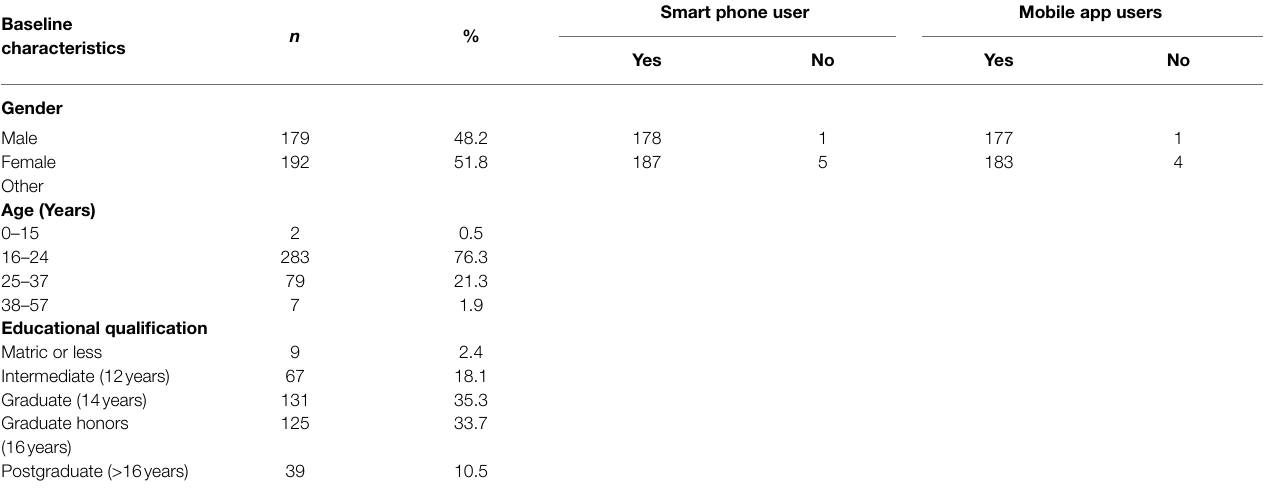
representation of gender distribution in Pakistan’s population. 76% of respondents are between the age of 16–24, and 21% of